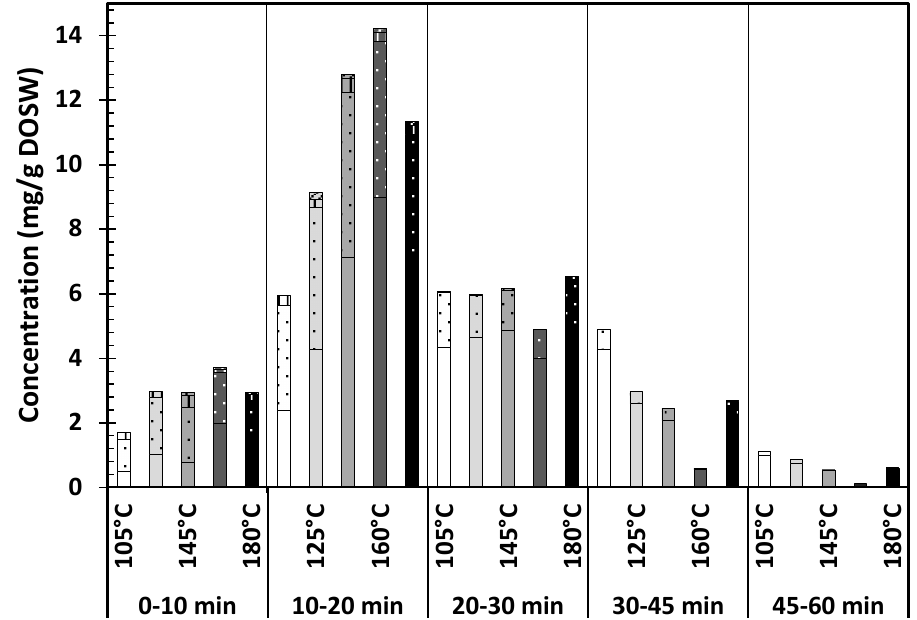
Figure 5. Total quercetins extracted as a function of the extraction time and the temperature. Solid color refers to QC; dotted to QC4 ′ ; vertical lines to QC3,4 ′ and diagonal lines to QC3. Ko et al. [20] reported 16.3 ± 0.8 mg QC / g onion (8 times higher than the obtained with ethanol ◦ (cid:48) / ◦ (cid:48) 60 C) and 3.15 mg QC4 g onion for extractions done at 165 C and 15 min. In total, the sum QC + QC4 accounted for the 99% of the total flavonoids present in the extract and approximately 92.4% of the total QC was recovered from the original